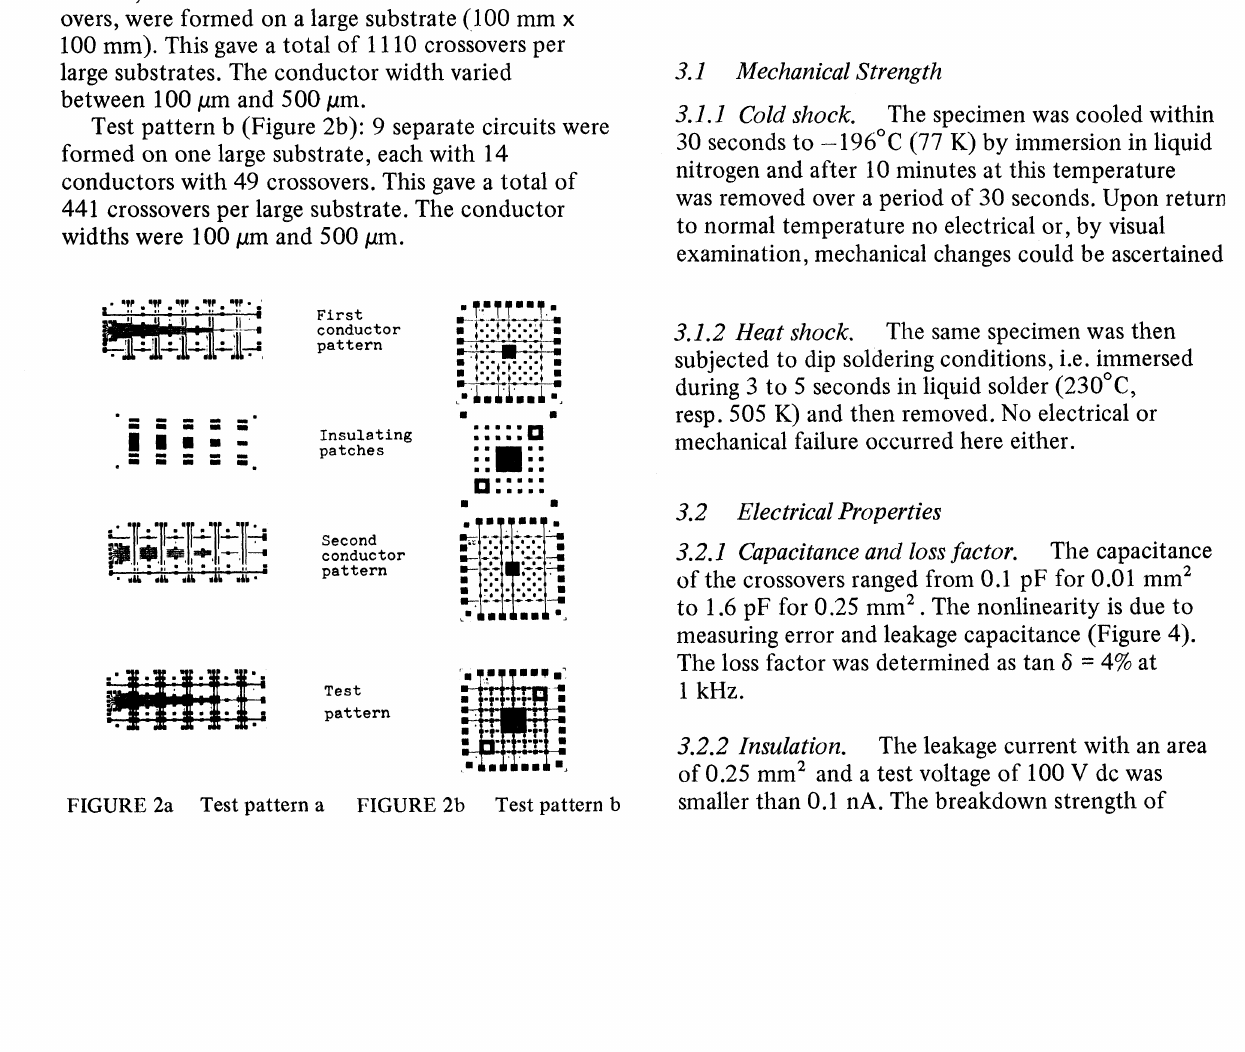
SEM photograph of a crossover of test pattern a) (magn.